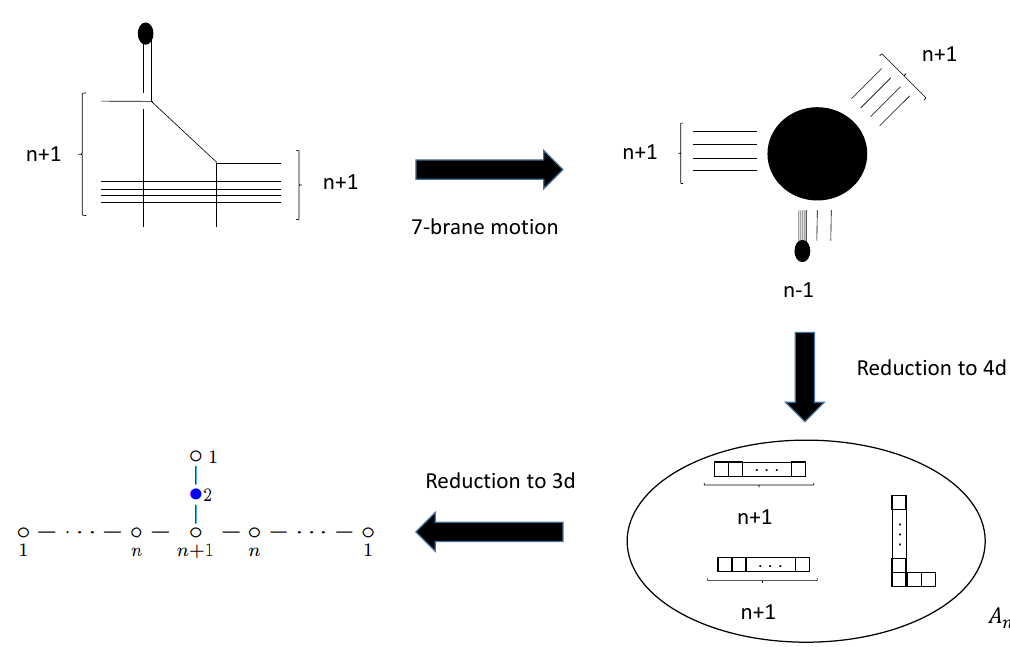
Figure 1 . Deriving the 3d quiver using the brane web. At the top left is the 5d brane web describing an SU( n ) 1 + (2 n + 1) F gauge theory. Moving the top 7-brane to the bottom leads to 2 the web on the top right. This one is in the form of [46] and so reduces to the class S theory shown on the bottom right when compacti(cid:12)ed on a circle to 4d. Further compacti(cid:12)cation on a circle to 3d leads to the 3d quiver.